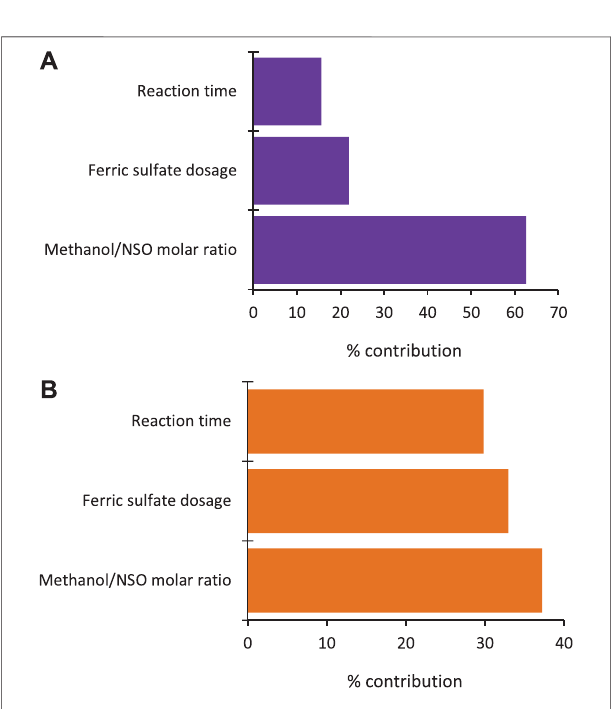
FIGURE 10 | Sensitivity level of input variables, (A) RSM and (B)